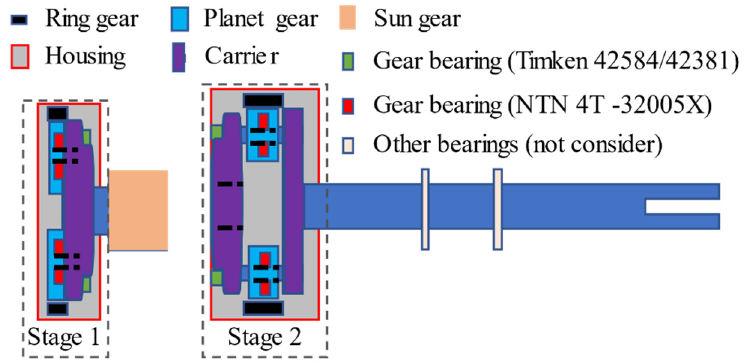
Figure 4. The structure of Stages 1 and 2 planetary gearboxes [14].